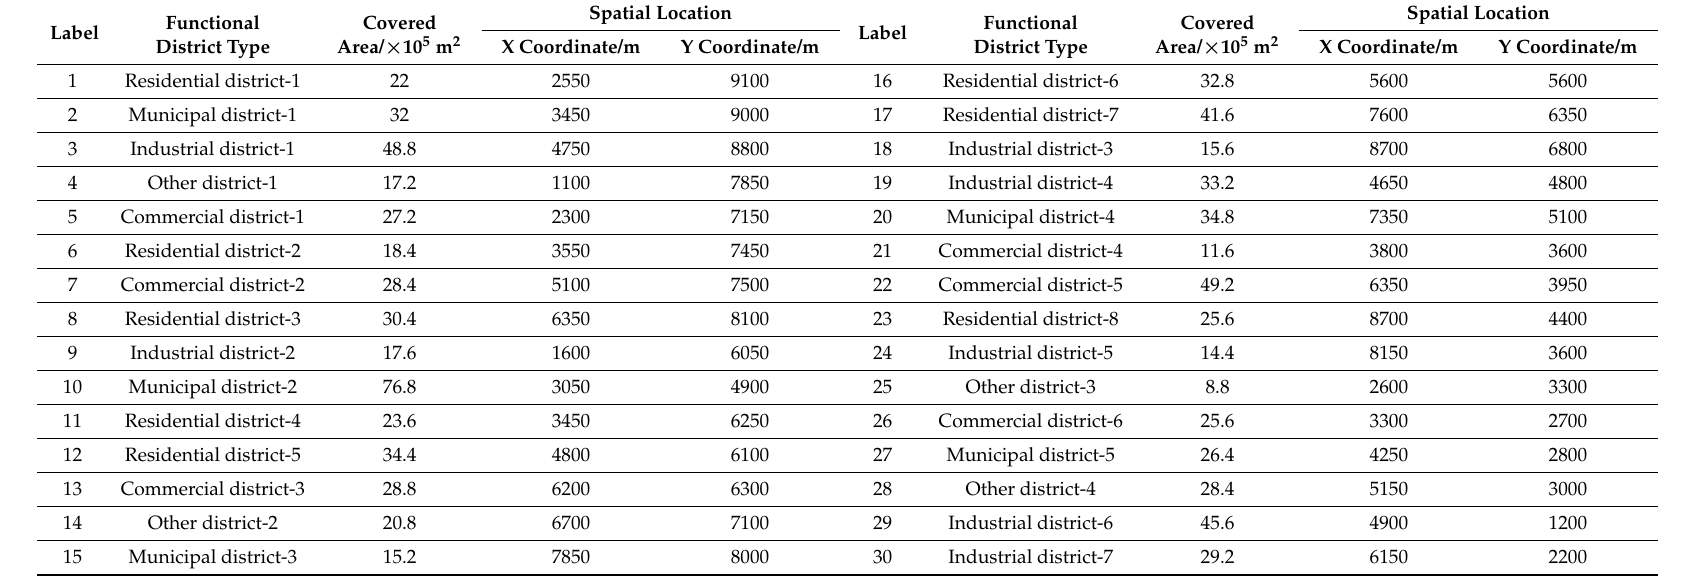
Table A1. Planning information for various functional districts in a typical new